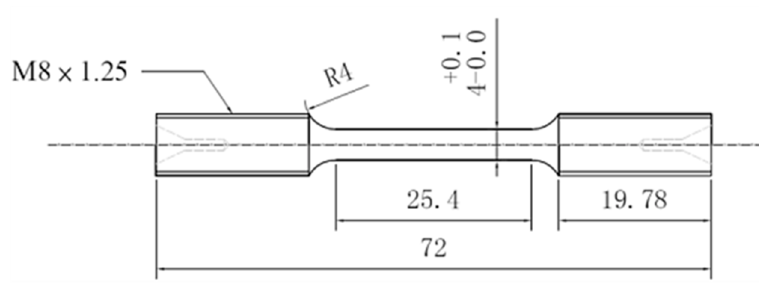
Figure 4. Dimensions of tensile test specimen.